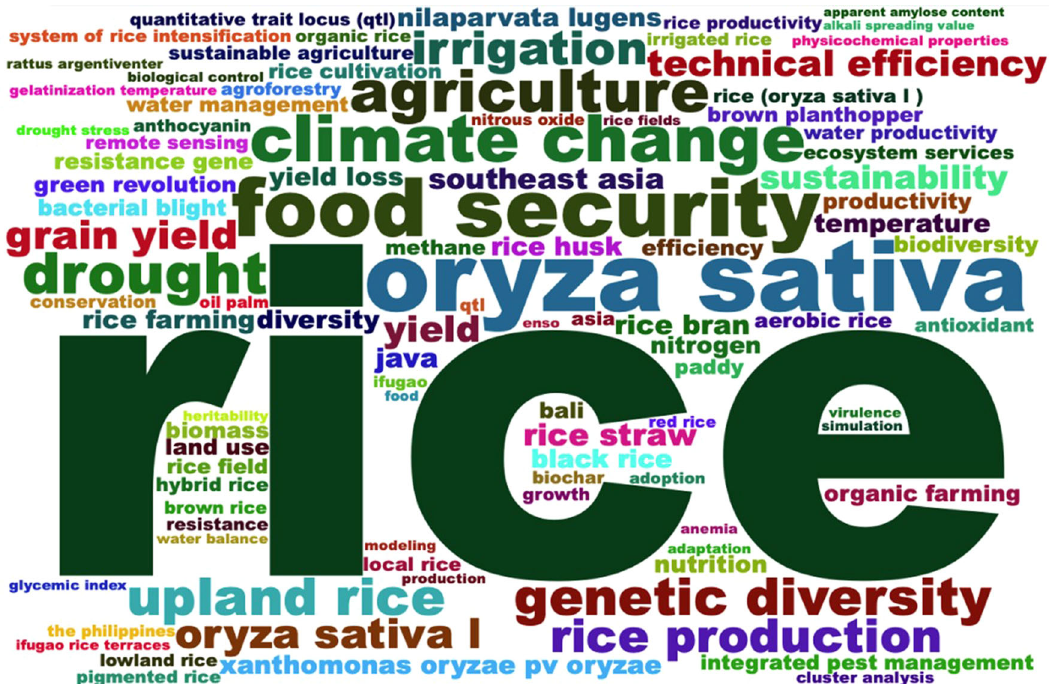
Fig. 10 Top 100 keywords on rice research in Indonesia and the Philippines since 2001, n = 6482 authors ’ keywords. The most used keywords found in 2243 rice research papers published between 2001 and 2021 in Indonesia and the Philippines are food security, climate change, drought, agriculture, irrigation, genetic diversity, sustainability, technical ef fi ciency, and production.